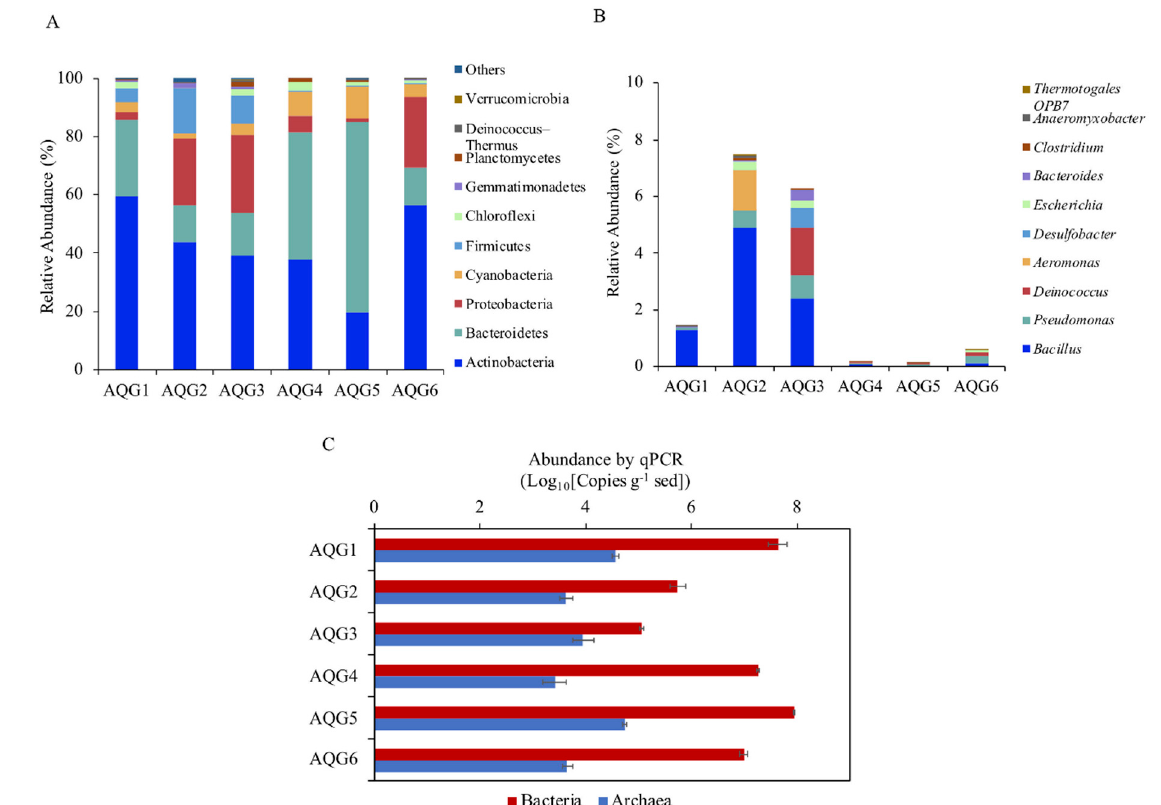
Figure 3. ( A ) Relative abundance of prokaryotes at phylum level (top 10) in the six rock layers. “Others” is the sum of the relative abundances at phylum level out of the top 10. ( B ) Relative abundance of iron-reducing bacteria at the genus level (top 10) in the six rock layers. Mean relative abundance of microorganisms in three parallel samples taken from each rock. The height of each column represents relative abundance, and the color represents a particular phylum or genus. ( C ) 16S rRNA gene copy numbers of archaea and bacteria in the six rock layers. ( A – C ) The value indicates the means of 3 replicates and error bars are represent standard deviations.